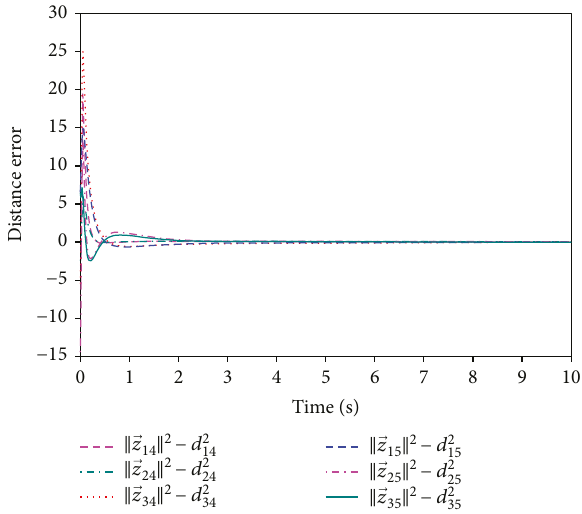
Figure 3: Trajectories of agents in a 3D space: agent ν are in the same Orientation 1.